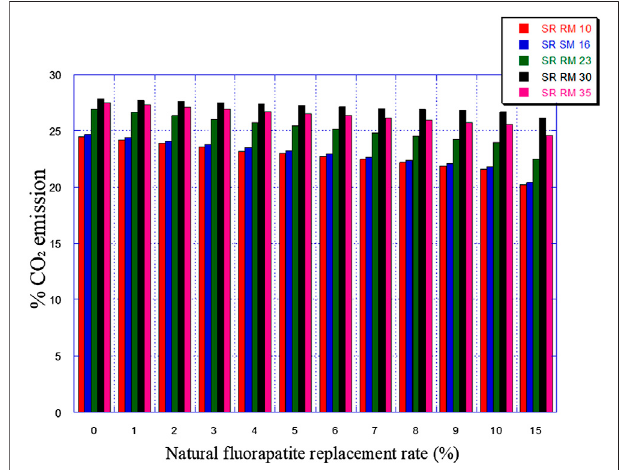
2 emissions in function of the natural fl uorapatite